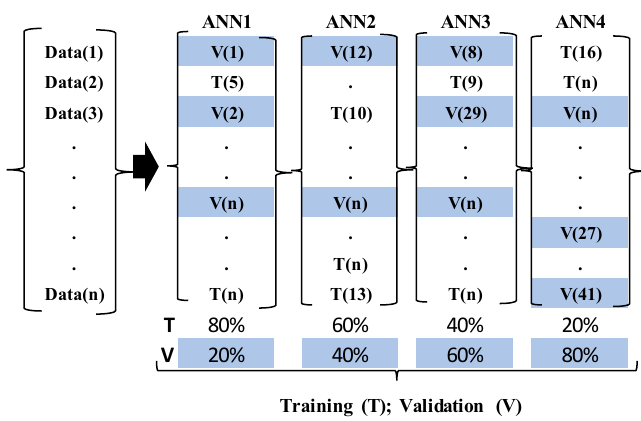
Figure 4. A randomization based four-fold cross-validation ensemble used for the ANN training and validation of the dataset.